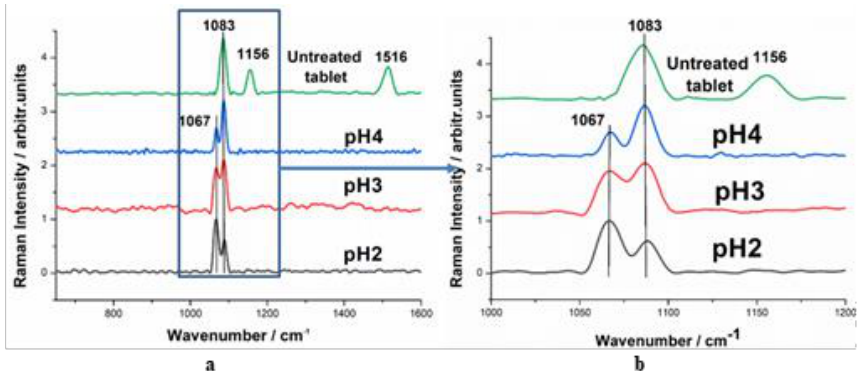
Figure 6. Confocal Raman spectra of the tablets exposed to acidic pH revealing a crystalline calcium carbonate signal as well as the monohydrocalcite signal, on the 700 – 1600 cm-1 spectral range ( a ) and 1000 – 1200 cm-1 spectral range ( b ).